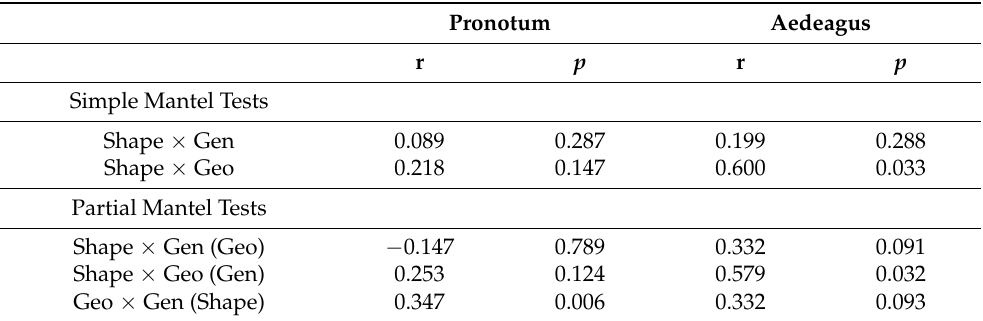
Table 5. Summary of simple (r) and partial (r (cid:48) ) Mantel tests for correspondence between morphologi- cal distances (Shape) and genetic (Gen) or geographic distances